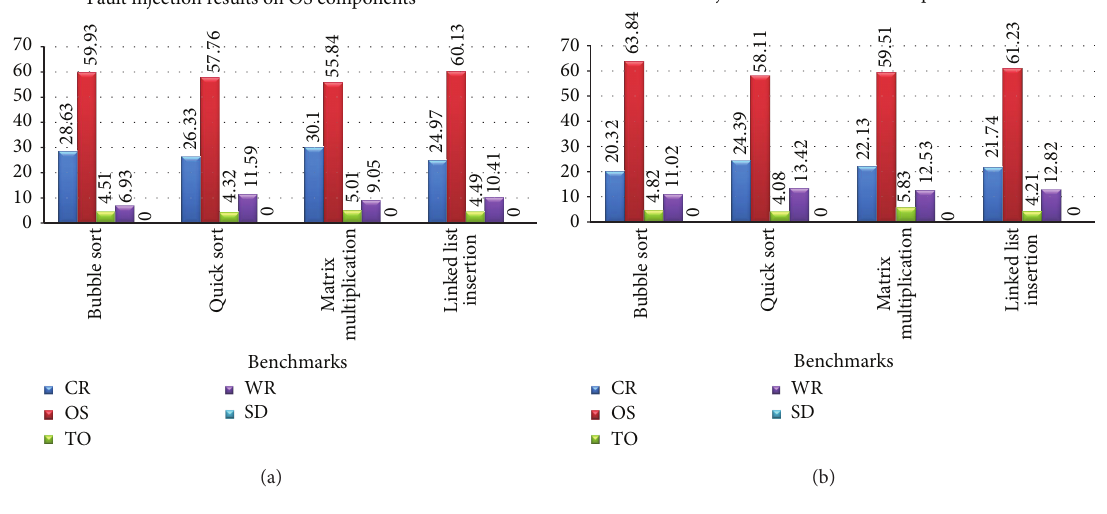
Figure 5: The average results from Tables 3 and